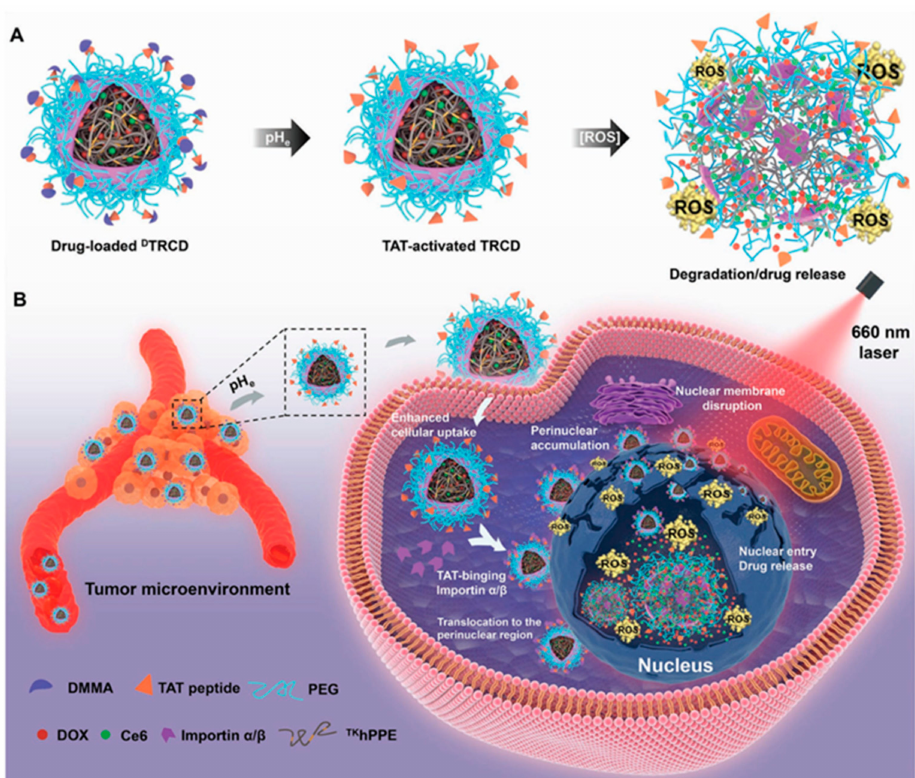
Figure 3. ( A ) Schematic diagram of the pHe/photosensitive decomposition of DTRCD. ( B ) Schematic illustration of the cascade nucleus-targeted drug delivery strategy of DTRCD. Adapted from